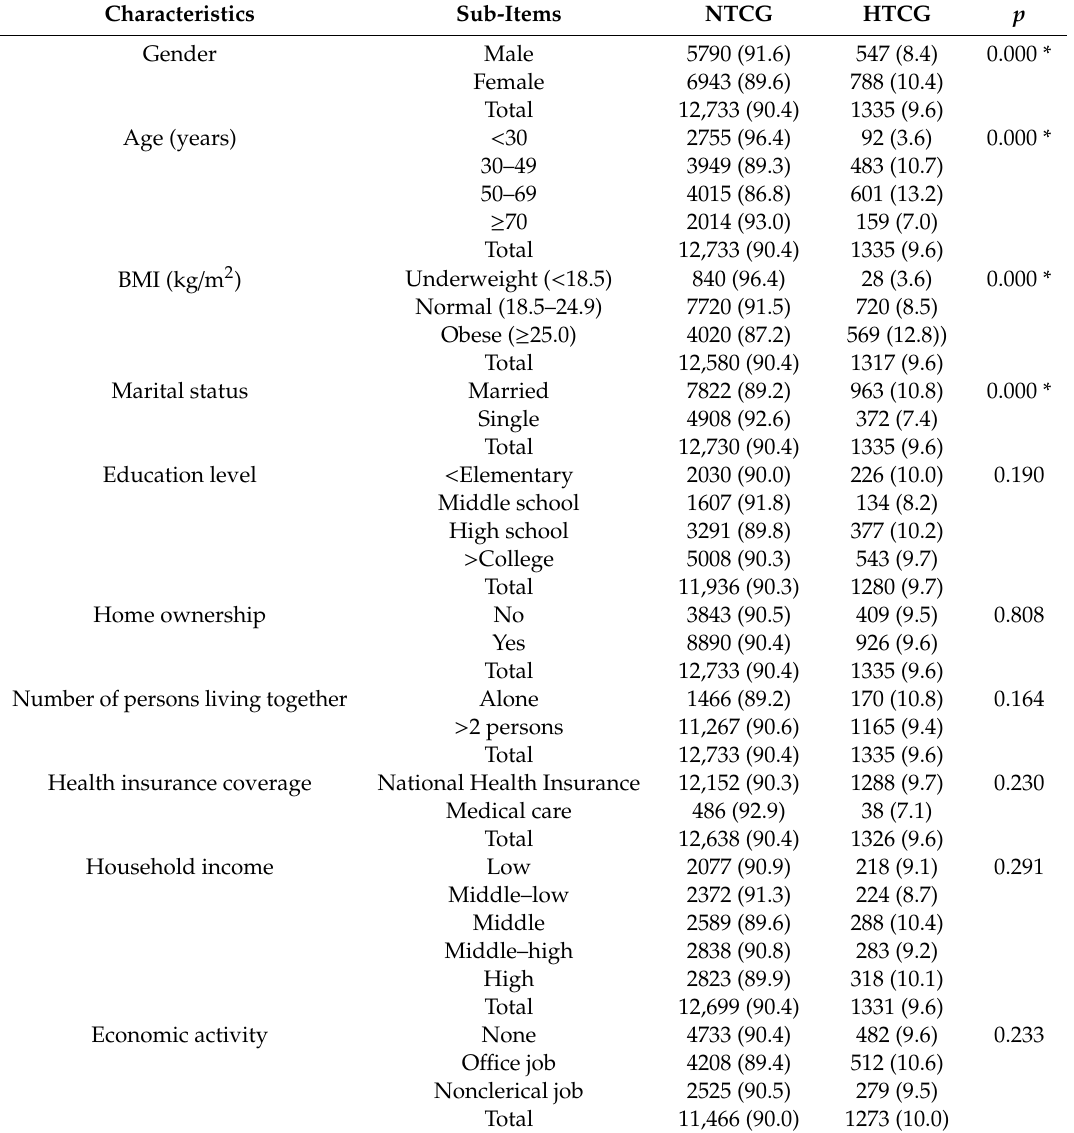
Table 1. Demographic characteristics by total cholesterol